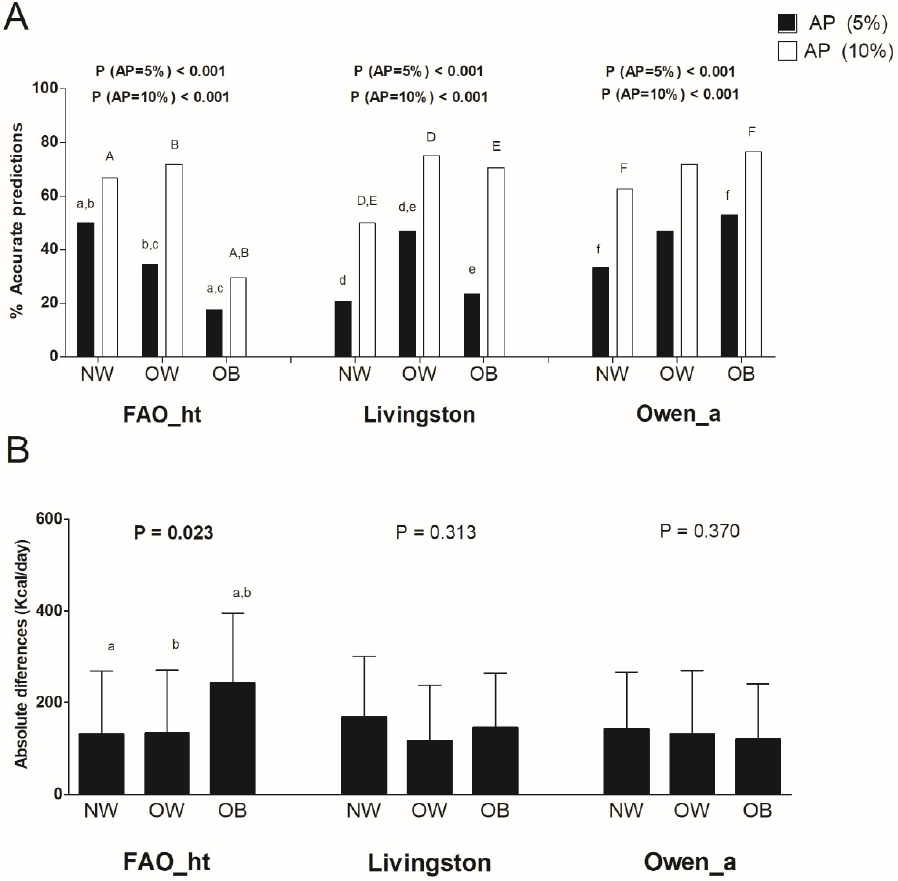
Figure 5. Percentage of accurate prediction of the most accurate predictive equations and mean differences between predicted and measured resting energy expenditure in absolute values by weight status. ( A ) Percentage of prediction accuracy at 5% and 10% of resting energy expenditure. ( B ) Mean (SD) differences between predicted and measured resting energy expenditure in absolute values; p value of an analysis of variance (with Bonferroni post-hoc analysis) across weight status. Similar letters (i.e., a-a, b-b) indicate significant differences ( p < 0.05) considering Bonferroni post-hoc analysis. AP: Accurate prediction; “_a” refers to predictive equations which require only anthropometric parameters to calculate REE, and “_ht” refers to predictive equations which are proposed by the same author and include height.